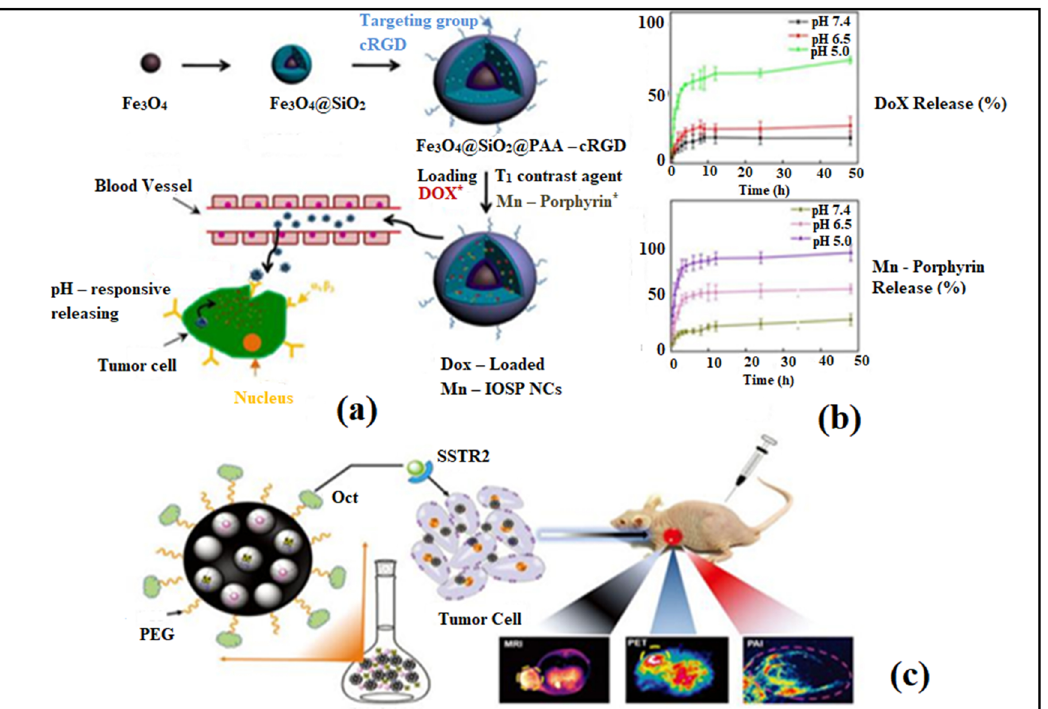
Figure 3: ( a ) Schematic presentation of synthesis, release, and imaging process of Fe 3 O 4 @SiO 2 @PAA - cRGD. Reprinted from ref. [ 111 ] by Creative Commons License. ( b ) Drug release study using UV - Vis spectra. Reprinted from ref. [ 112 ] by Creative Commons License. ( c ) Schematic presentation of the synthesis of contrast agent and imaging mode ( MRI/PET/PAI ) . Reprint from ref. [ 70 ] by Creative Commons